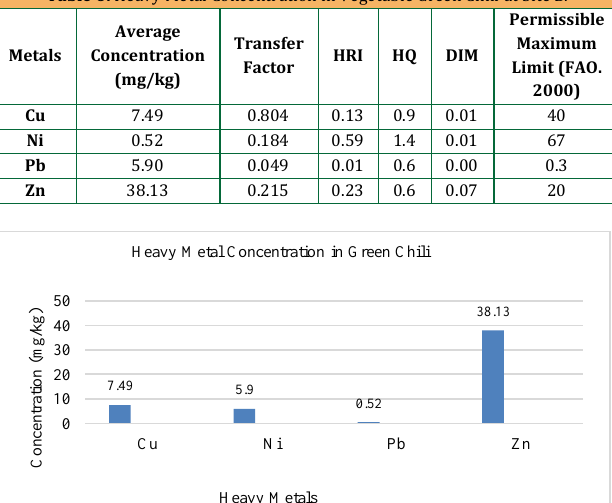
Table 6: Heavy Metal Concentration in Vegetable Green Chili at Site B.